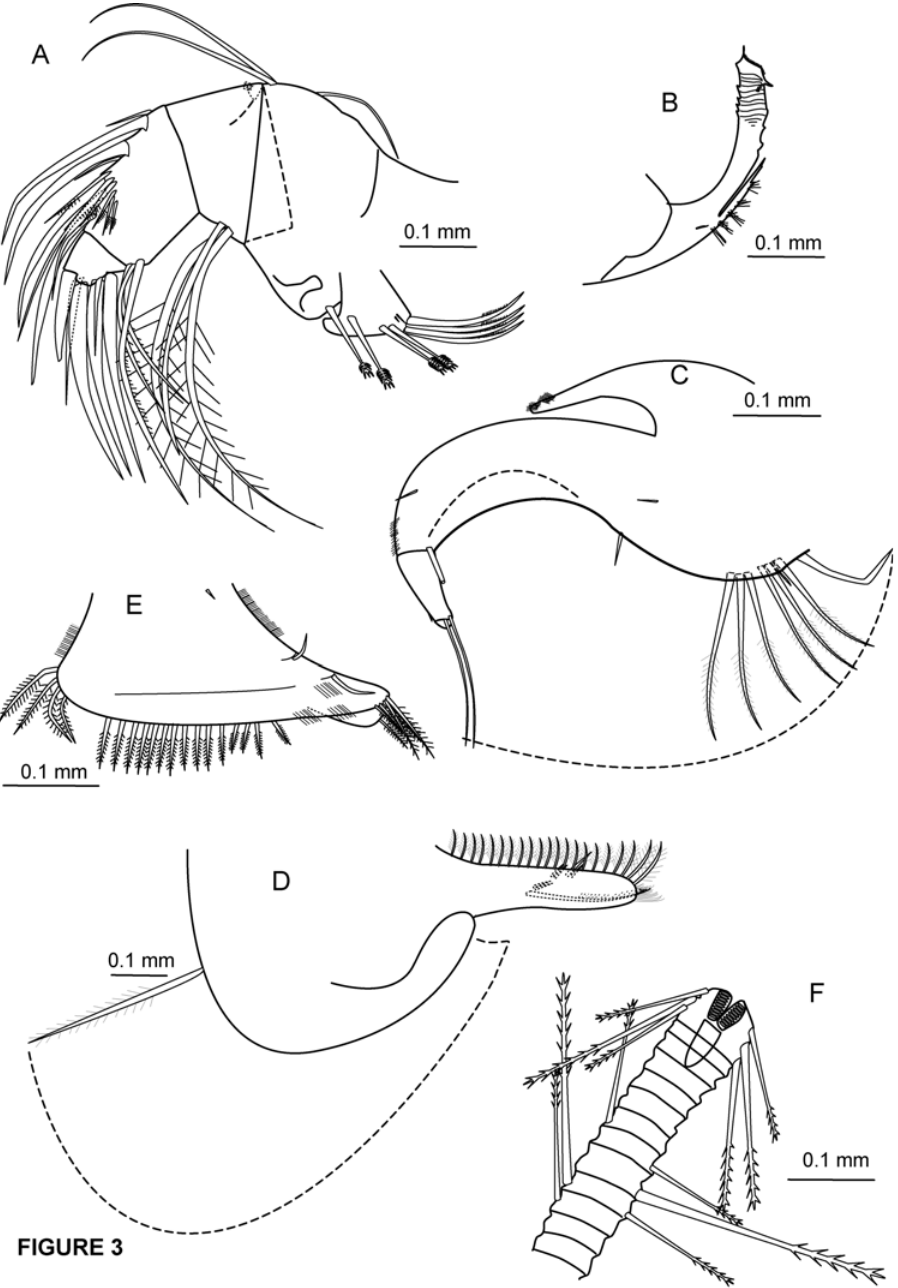
Figure 3. Cylindroleberismariae , adult female, specimen number NMSZ 1996.004.293. A, mandible, right, m.v. Cylindroleberis mariae , adult female, NMV J53222; B, coxale endite of mandible, right, m.v. Cylindroleberis mariae , adult female, specimen number NMSZ 1996.004.293; C, maxilla (fourth limb), left, l.v., setal comb setal limits shown by dotted lines, basale ventral distal seta broken; D, fifth limb, right, l.v., setal fan limits shown by dotted lines; E, sixth limb, left, m.v.; F, seventh limb.